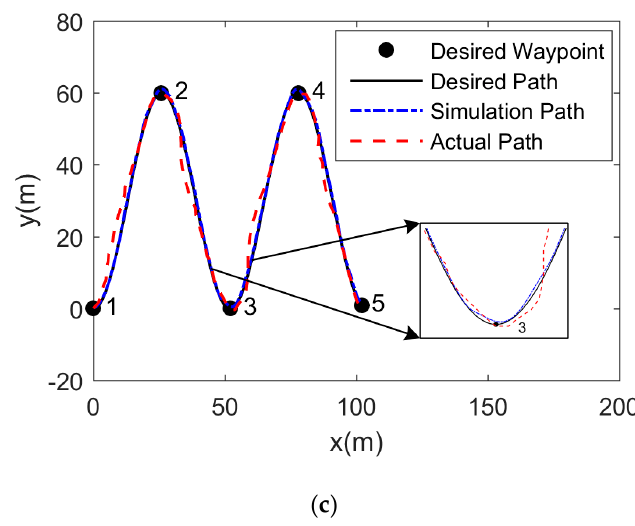
Figure 14. The simulation and experimental results of the simulation path, actual path and desired path: (a) line path; (b) circle path; (c) zigzag path.